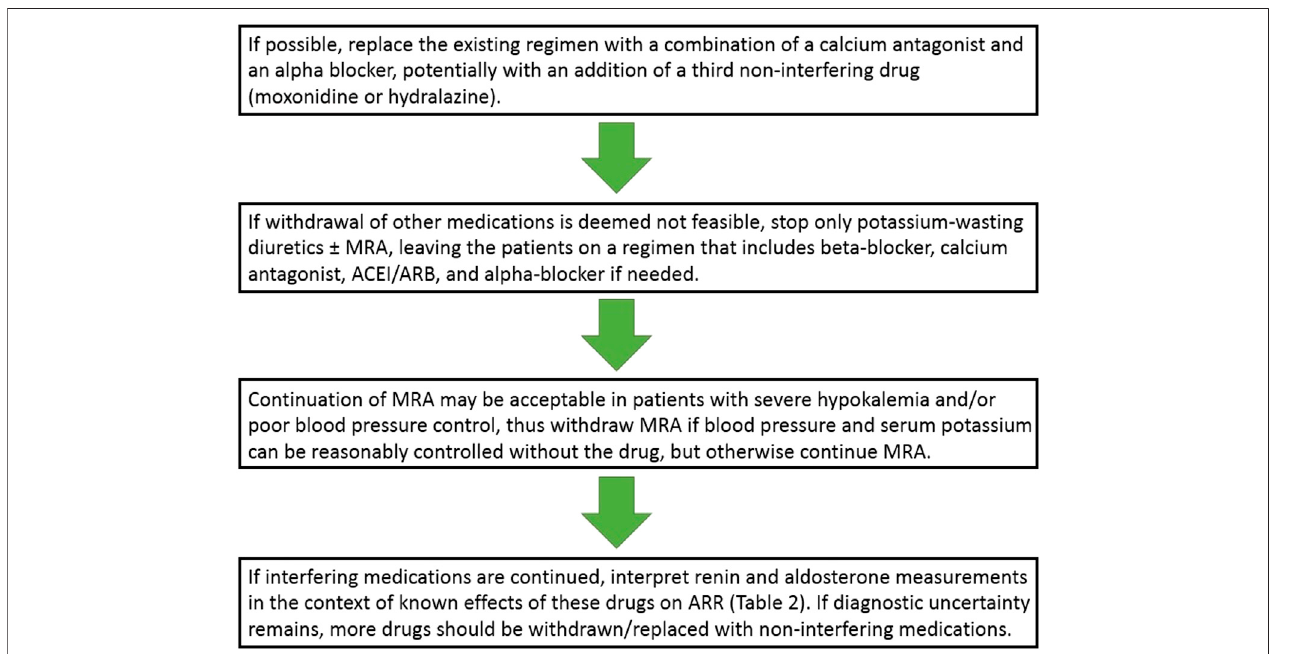
FIGURE2 | Approach toantihypertensive drug regimen modi fi cations when screening for primary aldosteronism. ACEI, angiotensin-converting enzyme inhibitors; ARB, angiotensin receptor blockers; ARR, aldosterone-to-renin ratio; MRA, mineralocorticoid receptor antagonist.